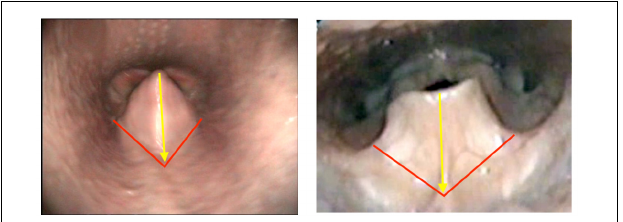
FIGURE 5 | Endoscopic photographic images during exercise of: (left) epiglottic retroversion in an equine. (Right) Epiglottic retroversion in a human. Red lines denote expected margins of epiglottis in a normal subject. Yellow arrows denote degree of collapse to normal.